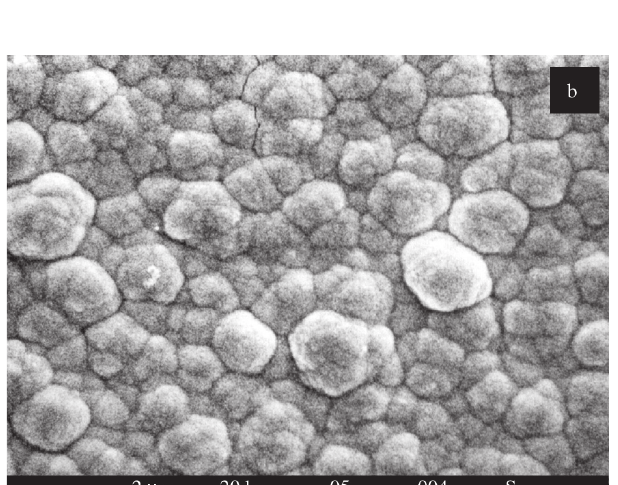
Figure 4. Morphology of coatings from Bath 4: a) 116 A/m 2 ; b) 154 A/m 2 .